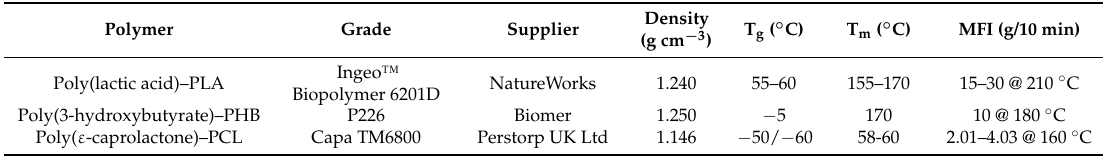
Table 4. Summary of the commercial grade polymers used for blends manufacturing and some of their relevant properties.